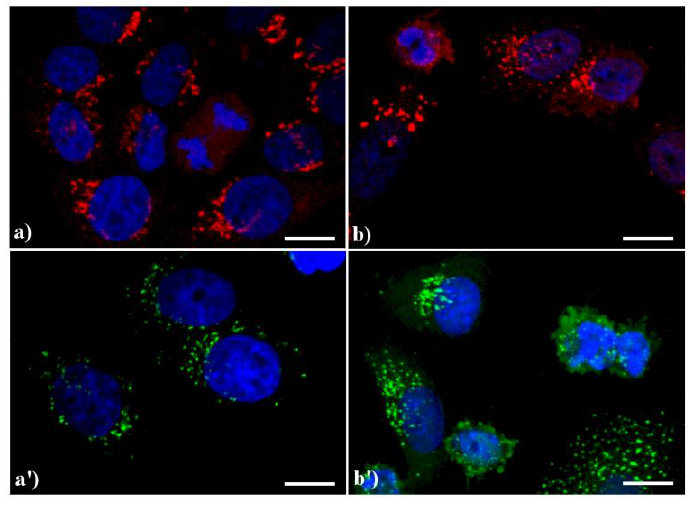
Figure 3. Confocal optical sections after immunolabeling for Golgi apparatus (GA). ( a , a' ) control HeLa cells; ( b ) cells treated with 1 μg/ml actinomycin D for 20 h; ( b' ):